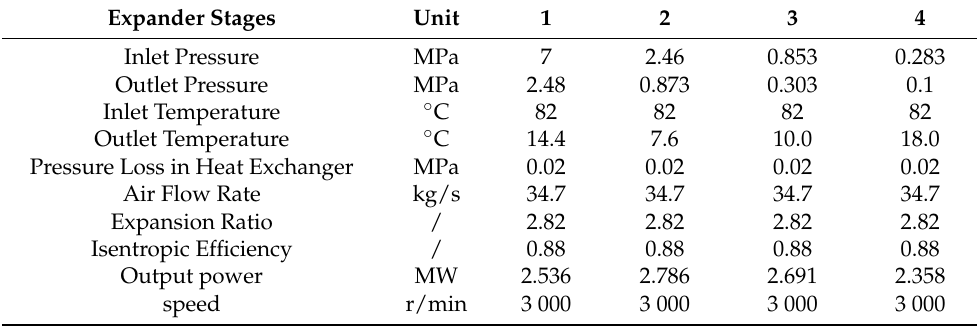
Table 3. Operation parameters in the mode of short